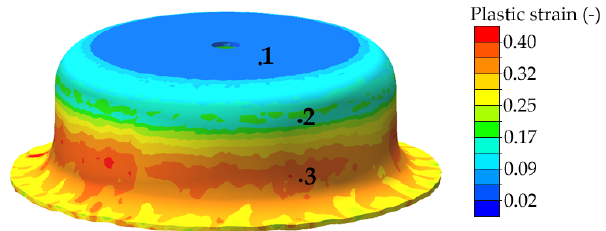
Figure 12. Contour levels of the plastic strain after the forming process for the X12Cr13 alloy after austenitization at 1050 °C and 900 °C initial forming temperatures.